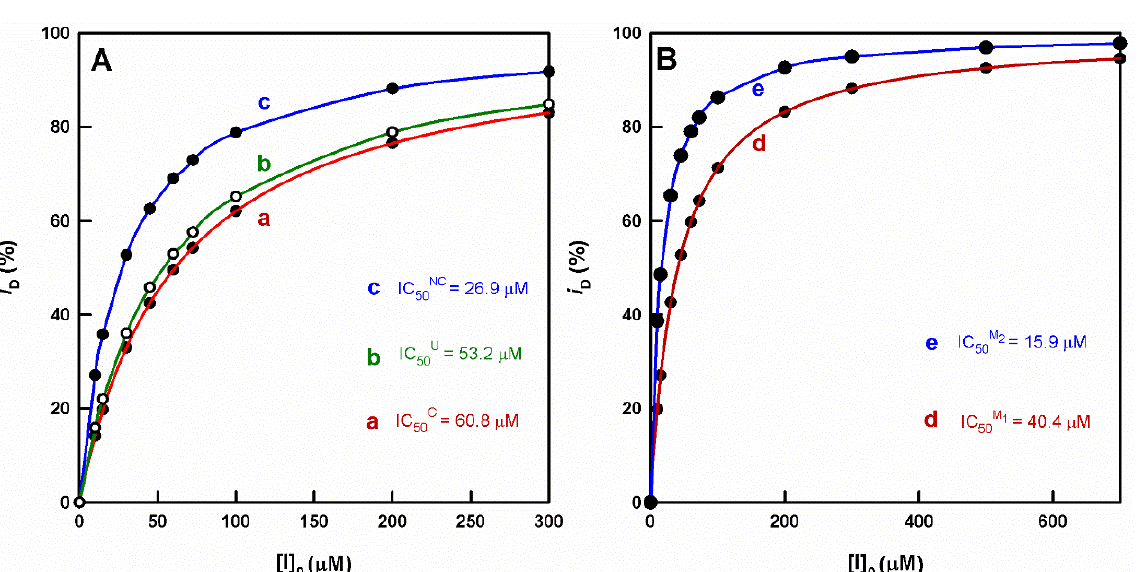
Table 4. Determination of the IC 50 values for the different types of inhibition.